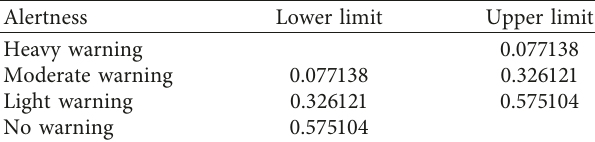
Table 6: Classification of food security